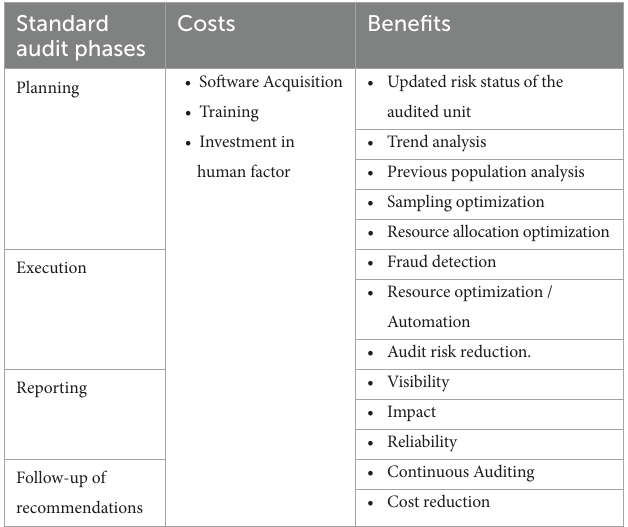
TABLE 2 Cost–benefit analysis of data analytics implementation.